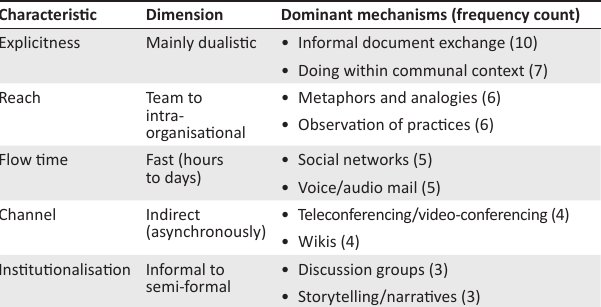
TABLE 14: Cluster 5 main characteristics and dominant knowledge transfer mechanisms. Characteristic